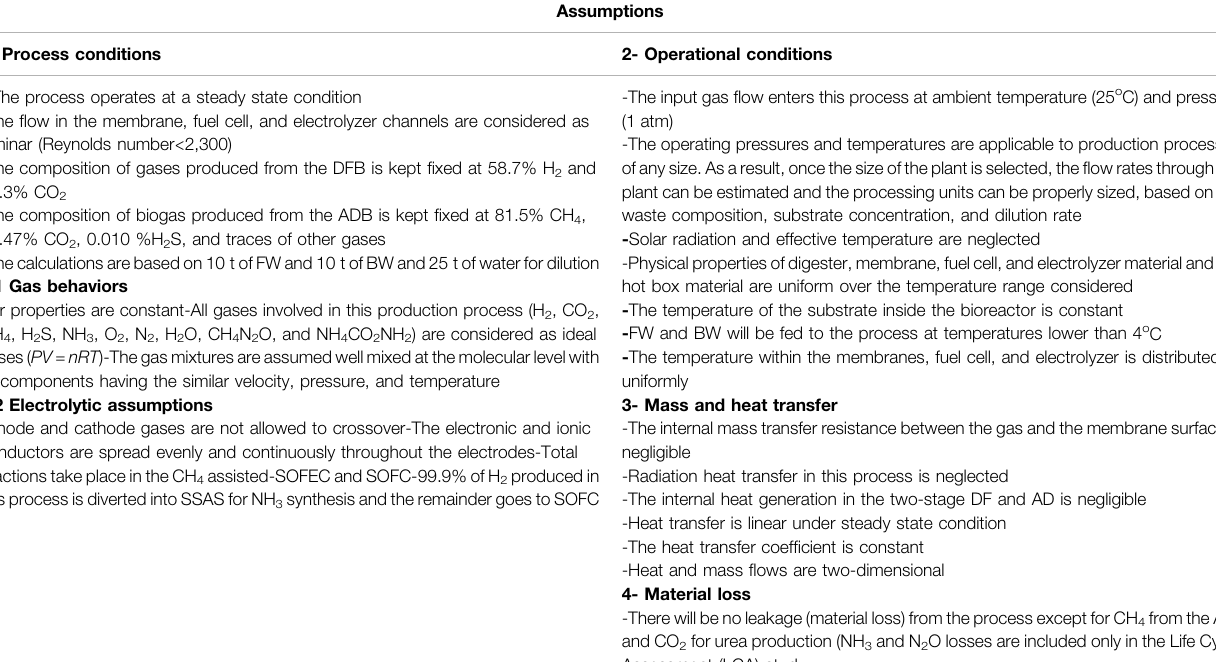
TABLE 2 | List of assumptions used in this